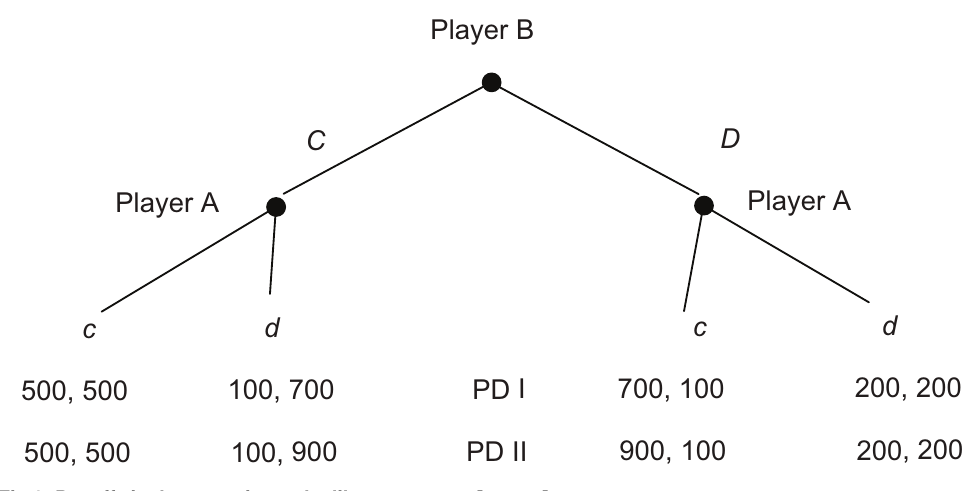
Fig 1. Payoffs in the two prisoner’s dilemma games [ π B , π A